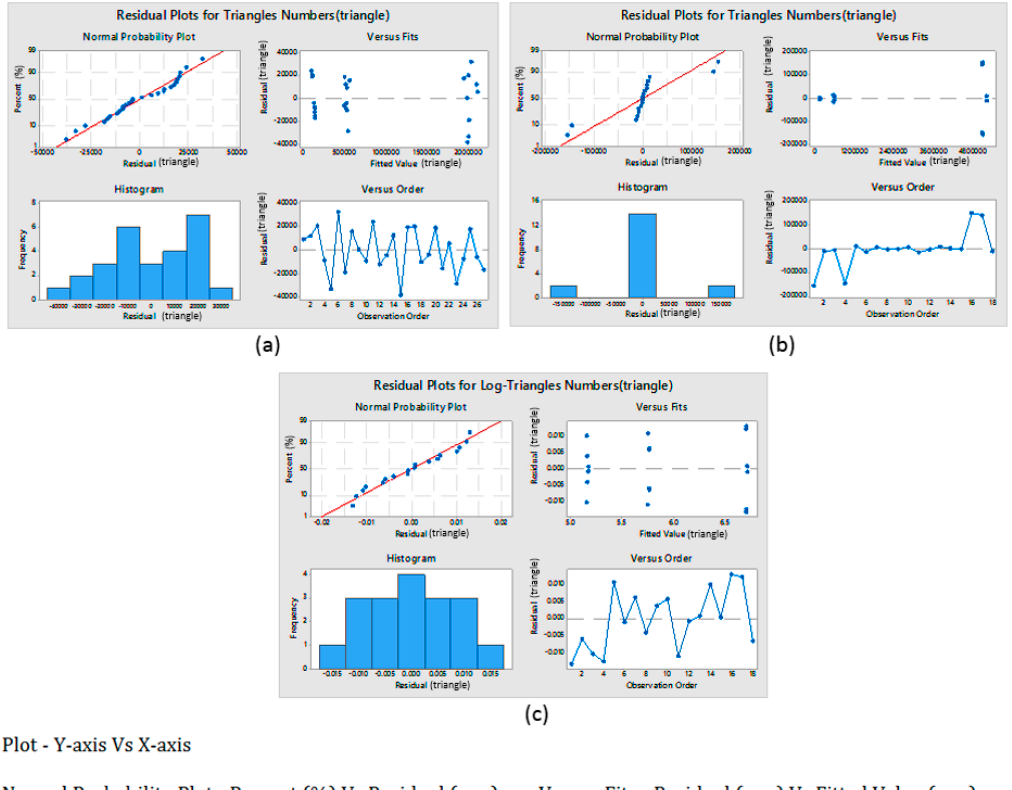
Figure 13. Normality test for triangle numbers ( a ) laser scanner; ( b ) white light scanner ( c ) Normality test for log-triangles numbers of white light scanner. Table 4. p -Values using ANOVA for the laser-based and white light handheld scanners (accuracy). Controlling